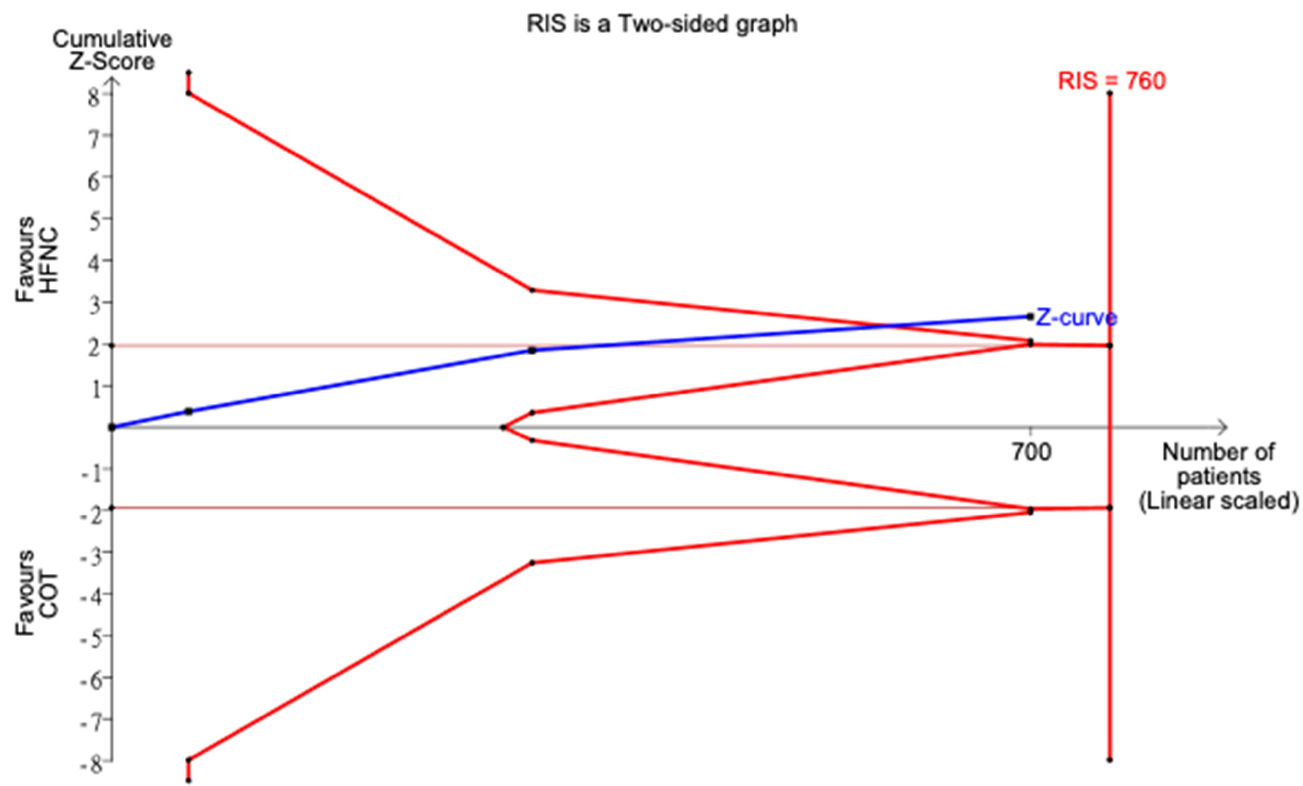
Figure A3. Trial sequential analysis: incidence of hypoxemia (studies with overall low risk of bias).